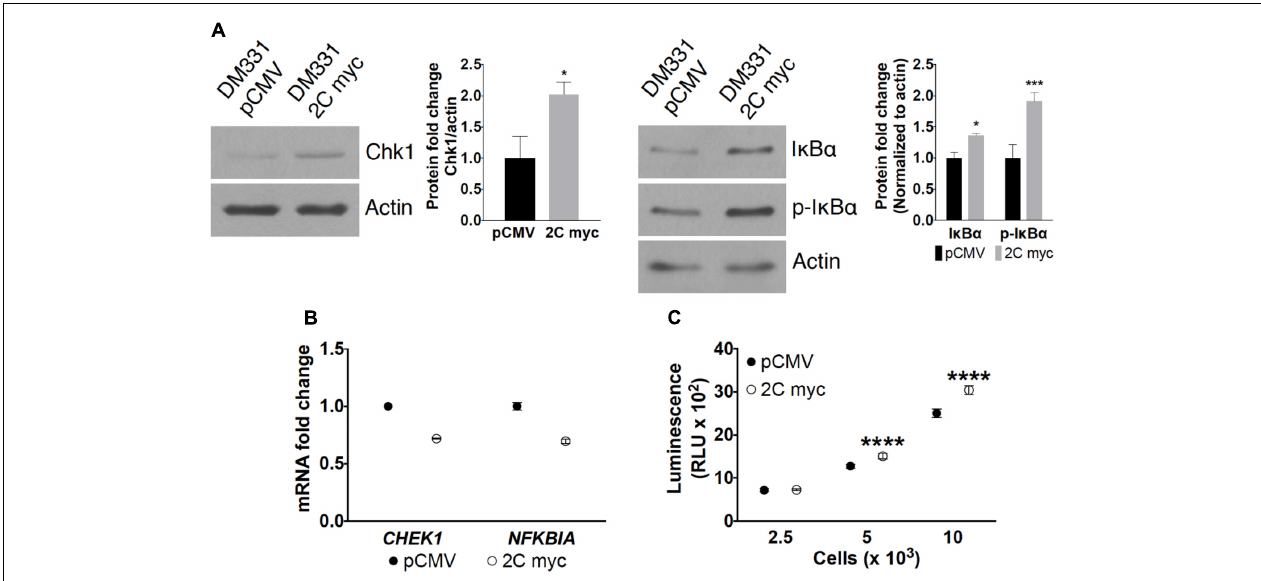
FIGURE 5 | Effect of LAMP-2C expression on CMA substrates. (A) Cellular levels of CMA substrates Chk1, I κ B α , and p-I κ B α in DM331 pCMV and DM331 2C myc cells were examined by western blotting. Relative protein levels were calculated by setting the normalized expression to one for DM331 pCMV cells. (B) mRNA levels of CHEK1 and NFKBIA transcripts were analyzed by qPCR and normalized to ACTB expression. mRNA levels in DM331 pCMV cells were normalized and set to one. (C) Proteasome activity was measured using the Proteasome-Glo Chymotrypsin-Like Cell-Based Assay. Cells were incubated with a substrate succinyl-LLVY-aminoluciferin which penetrates into the cytoplasm. This substrate is cleaved by the proteasome to release aminoluciferin which is released from cells. Luciferase is added to these cells, cleaving aminoluciferin to a luminescent product detectable using a luminometer. Data were analyzed by two-way ANOVA or by two-tailed, unpaired Student’s t -test. ∗ p < 0.05, ∗∗∗ p < 0.001, and ∗∗∗∗ p < 0.0001 ( n =